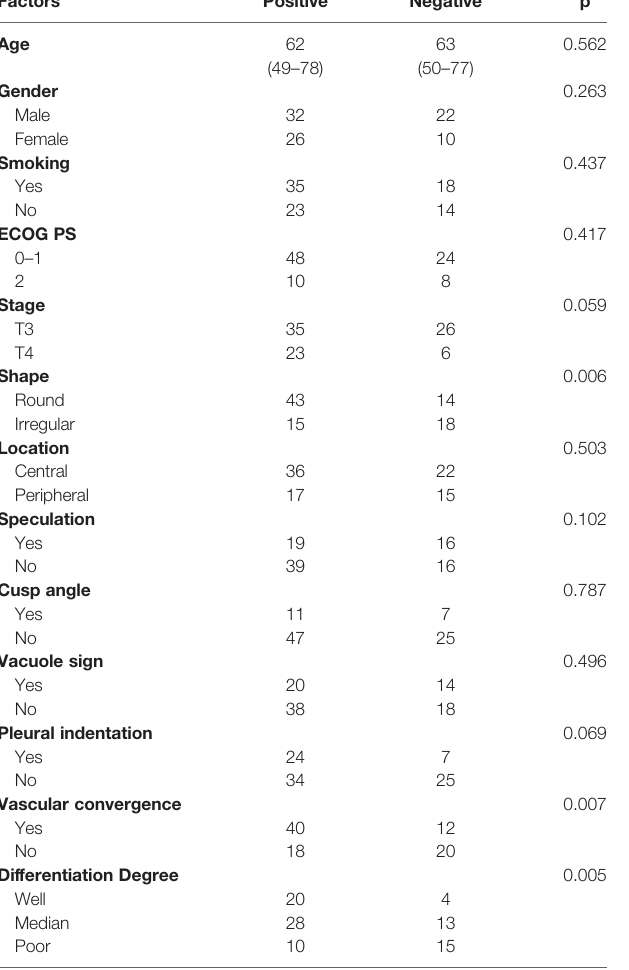
TABLE 3 | The correlation of TMB status and clinicopathological with CT morphological factors.